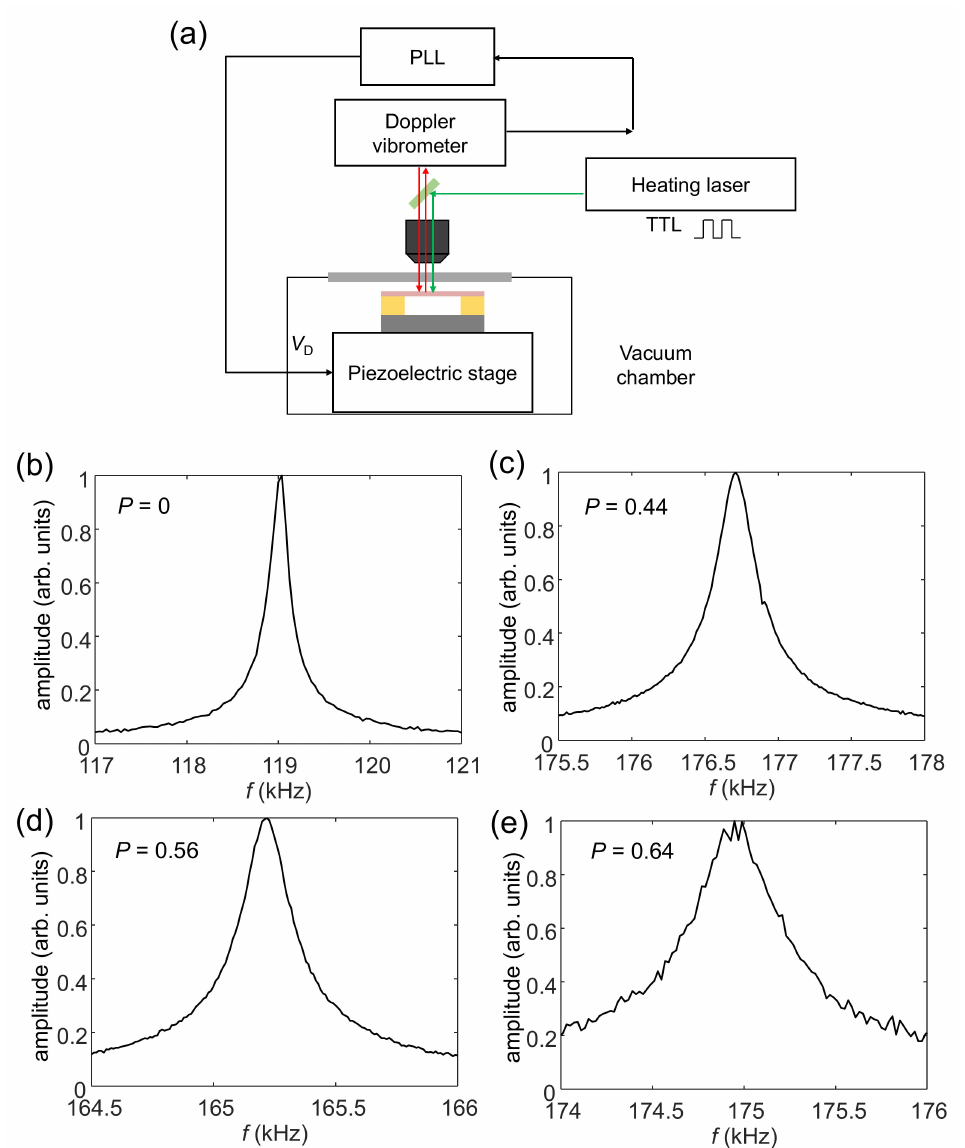
Figure 3. ( a ) The experimental setup used to measure the mechanical oscillations and thermal conductance of the MEMS beam. A piezoelectric block was used to drive vibrations in the MEMS beam, and the induced oscillatory motion was monitored with a laser Doppler vibrometer. A lock-in amplifier with a built-in PLL was used to measure the oscillation spectra. A 520 nm TTL-modulated laser diode was used to heat the MEMS beam. ( b ) The resonance spectrum of a MEMS beam without any nanomesh structure for the first bending mode, of which the resonance frequency was ~119 kHz and the quality(Q)-factor was ~1000. ( c ) The resonance spectra with nanomesh structures ( P = 0.44) at a resonance frequency of ~176.5 kHz and a Q-factor of ~900. ( d ) The resonance spectrum with a nanomesh structure ( P = 0.56) at a resonance frequency of ~165 kHz and a Q-factor of ~1000. ( e ) The resonance spectrum of the nanomesh structure ( P = 0.64) at a resonance frequency of ~175 kHz and a Q-factor of